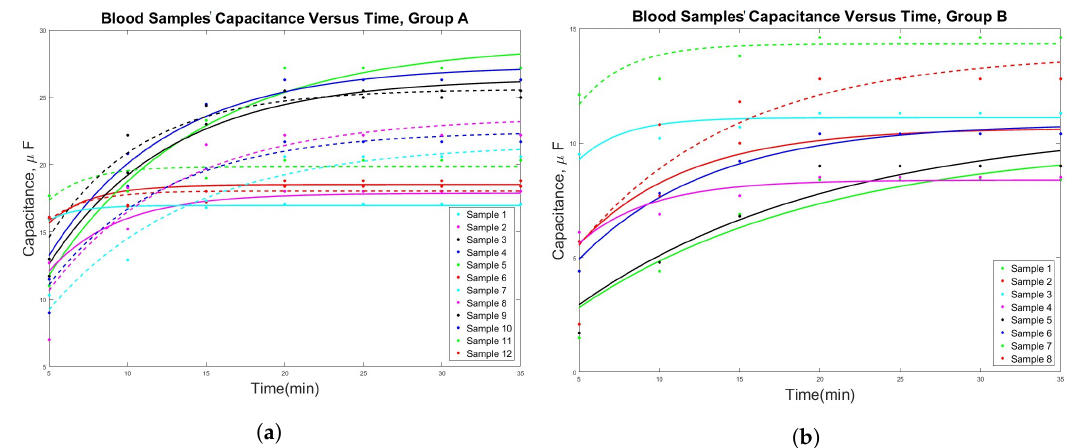
Figure 3. Diagrams of the capacitance versus time for the examined ( a ) cancerous (Group A) and ( b ) normal (Group B) samples. The plots were fitted to the data using MATLAB’s “cftool” with a general exponential equation. As can be observed, there is a clear difference between the two groups in the range of steady-state capacitance